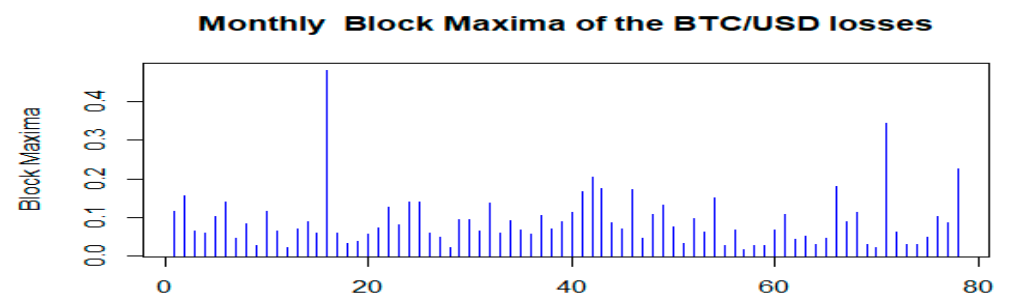
Figure 7. Block maxima for lower tail (losses) of BTC/USD.